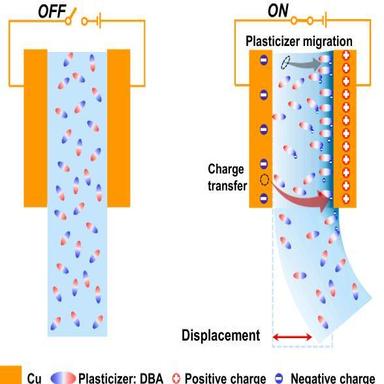
Schematic illumination of the deformation mechanism of PVC/DBA gel at electrical stimulation.